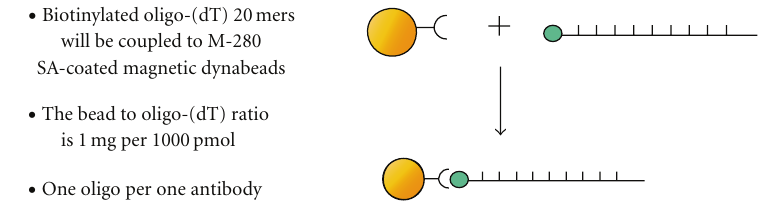
Figure 3: Oligo-dT beads